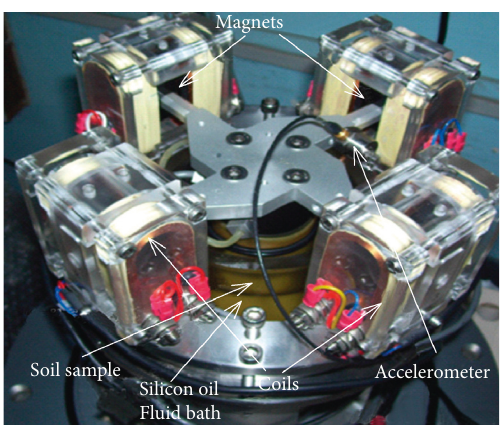
Figure 8: Photo of traditional resonant column (copy from Madhusudhan and Senetakis [18]).